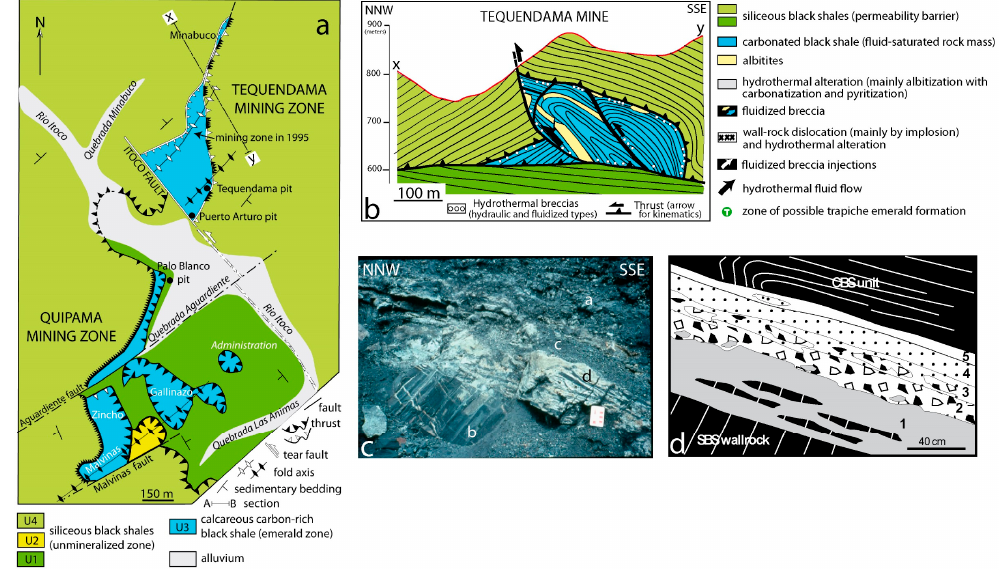
Figure 29. Tectonic style and lithologies of the Muzo emerald mining district, western emerald zone: ( a ) Geological map produced between 1994 and 1996. U1 through U4 represent the different tectonic units. The units, U1, U2, and U4, are comprised of barren siliceous black shales (cambiado), while U3 is composed of emerald-bearing calcareous carbon-rich black shale; ( b ) Tequendama mine cross-section along x-y (see Figure 29a). The cross-section shows the different lithologies and tectonic structures described by [112] and [107,113]. The thrusts and tear faults are associated with the presence of breccia, extensional veins, and related potential zones for trapiche emerald in the wall-rock dislocations and hydrothermal alteration [114]; ( c ) thrust verging NNW at Tequendama mine. The SSE dipping calcareous black shale unit ( a ) thrusts over the NNW dipping siliceous black shale unit ( b ). The siliceous beds are truncated at high angles by the thrust plane characterized by a hydrothermal breccia ( c ) and a thrust-parallel vein ( d ). Photograph: Gaston Giuliani; ( d ) texture and mineralogy of a